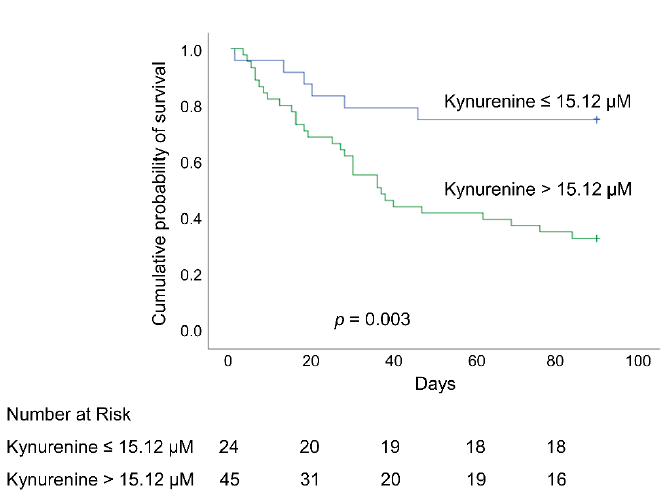
Figure 5. Kaplan–Meier 90 ‐ day survival curves of patients with ARDS, as stratified using an optimal cutoff value of plasma kynurenine (15.12 μ M) at day 1. ARDS: acute respiratory distress syndrome.